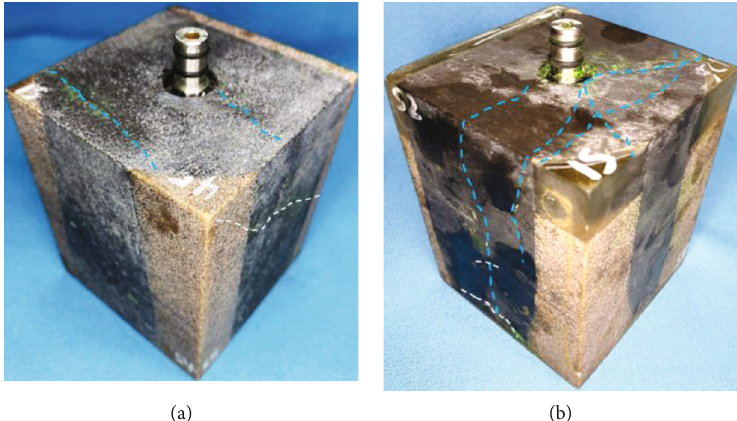
Figure 6: Diagram of sample after fracturing. (a) Sample 4#. (b) Sample